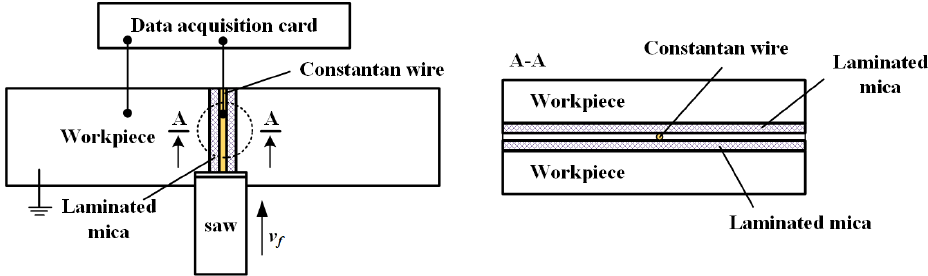
Figure 2. Schematic diagram of temperature measurement by semi-manual sandwich thermocouple method.